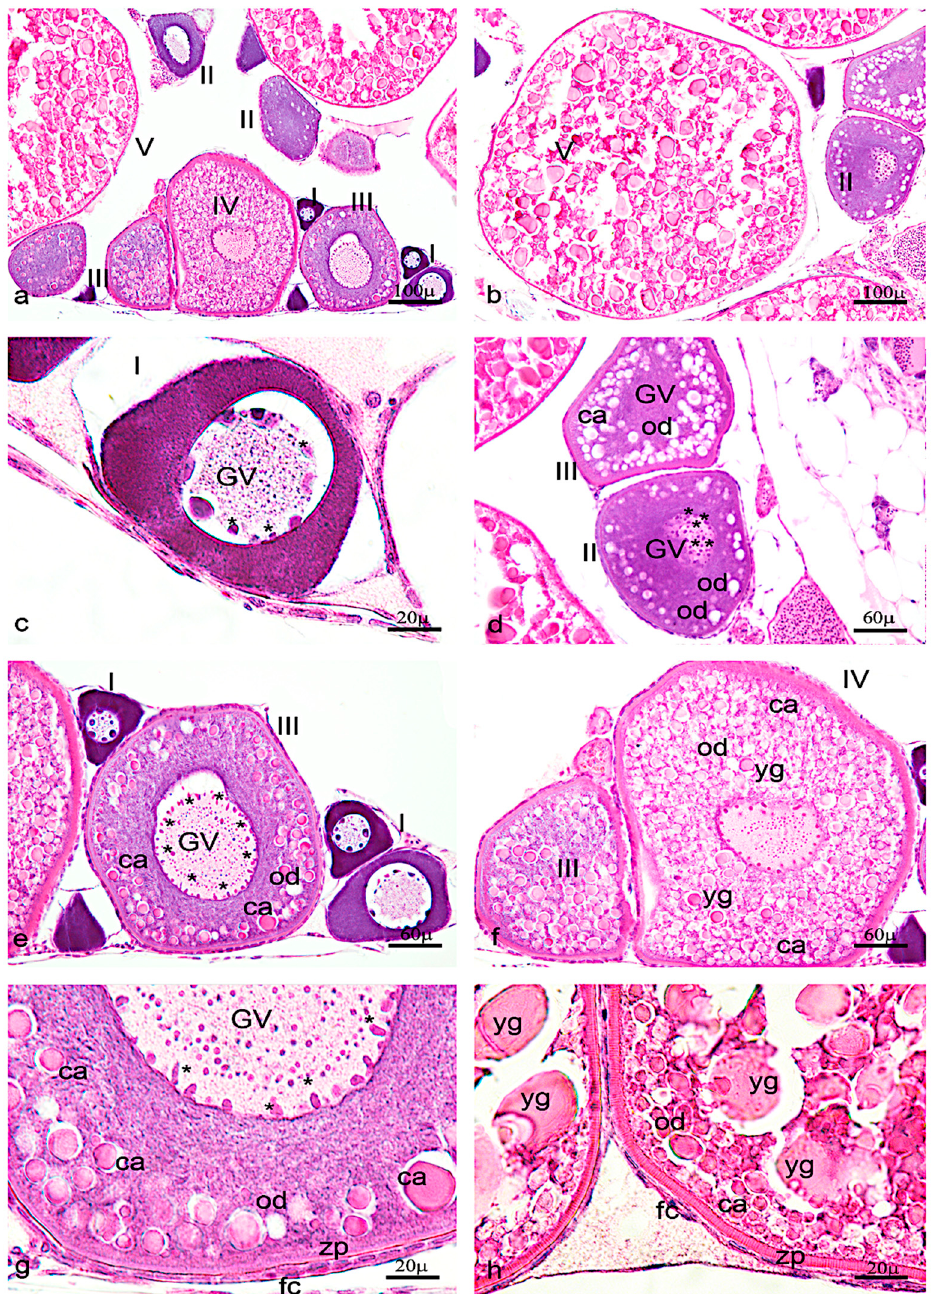
Figure 6. Hematoxylin-eosin staining of adult zebrafish ovary. ( a ) Overview of adult zebrafish ovary by hematoxylin-eosin staining, five oocyte stages (I-II-II-IV-V). ( b ) Oocyte stages II and V. ( c ) Oogonia characterized by large euchromatic germinal vescicle (GV), and several nucleoli peripherically located. ( d ) Oocyte during primary growth (stages II–III), characterized by an increase of nucleoli in GV, and in ooplasma were present oil droplets (od) around the GV. ( e ) Oocyte (stages III) characterized by numerous nucleoli at the periphery of GV. ( f ) numerous oil droplets and cortical alveoli (ca). ( g ) The oocyte (stages IV) is enveloped by zona pellucida (zp) and a single layer of follicular cells (fc). ( h ) Oocyte (stage V) characterized by a significant increase of number and size of the yolk globules (yg). Significant increase in the thickness of the zona pellucida and appearance of thecal layer. Scale bars are: 100 µ ( a , b ); 60 µ ( d – f ); 20 µ ( c , g , h ).